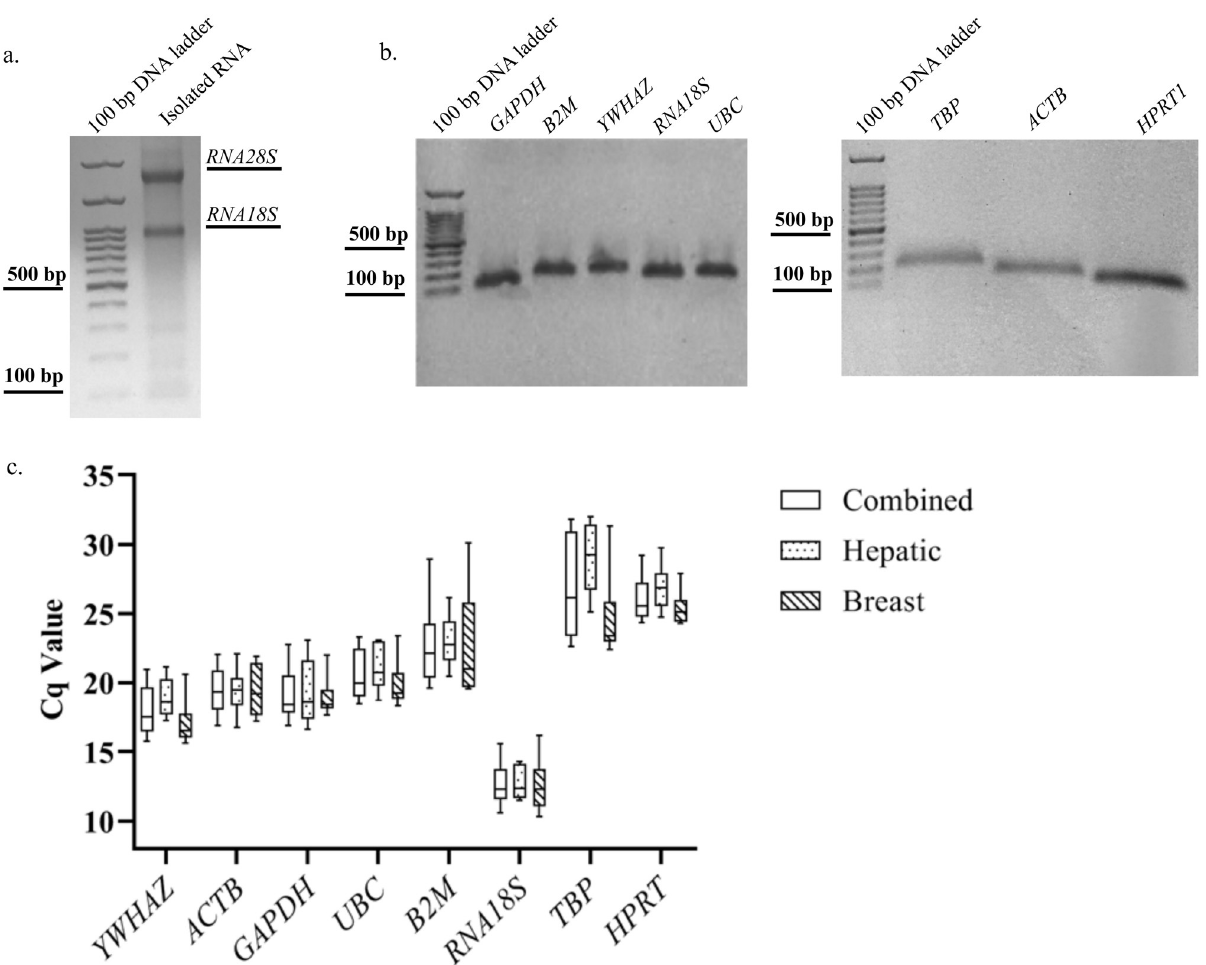
Fig 1. Expression of reference genes and Cq distribution in hepatic and breast cancer cell lines. A . Integrity analysis of the isolated RNA derived from SKBR3 cell line. The 2:1 ratio of RNA28S / RNA18S band intensities on 1% agarose gel confirmed the integrity of the extracted RNA. Similar results were obtained for the other five cancer cell lines. B . Specificity analysis of the designed primers. Based on the results obtained from agarose gel electrophoresis, a single band of each gene’s RT-qPCR product at the anticipated size confirmed the specificity of the used primers. The isolated RNA sample (Fig 1A), cDNA template, and the RT-qPCR products (Fig 1B) belonged to the SKBR3 cell line. Full-length gels are presented in S1 Fig. C . Cq values distribution of the nominee reference genes in three hepatic cancer cell lines, three breast cancer cell lines, and their combination. The graph is provided as box and whiskers that the latter shows 10–90